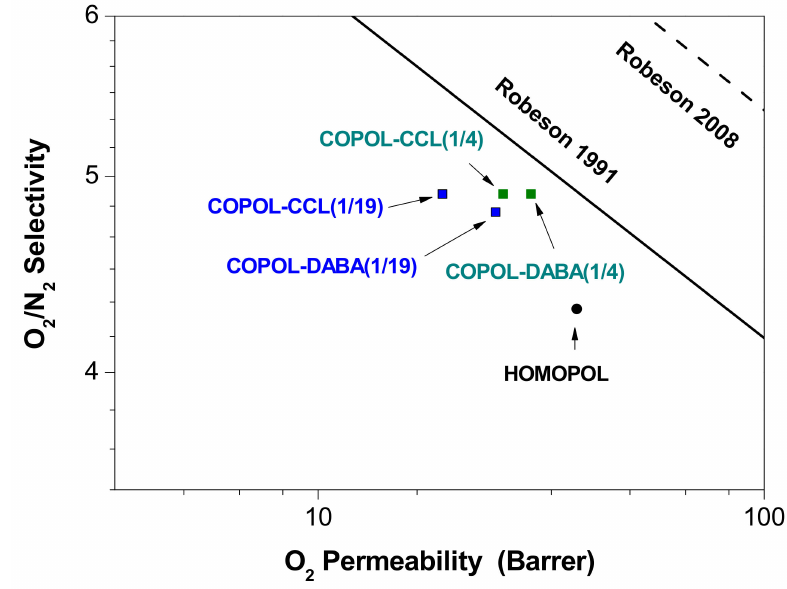
Figure 12. O 2 /N 2 selectivity vs. O 2 permeability [71,72].